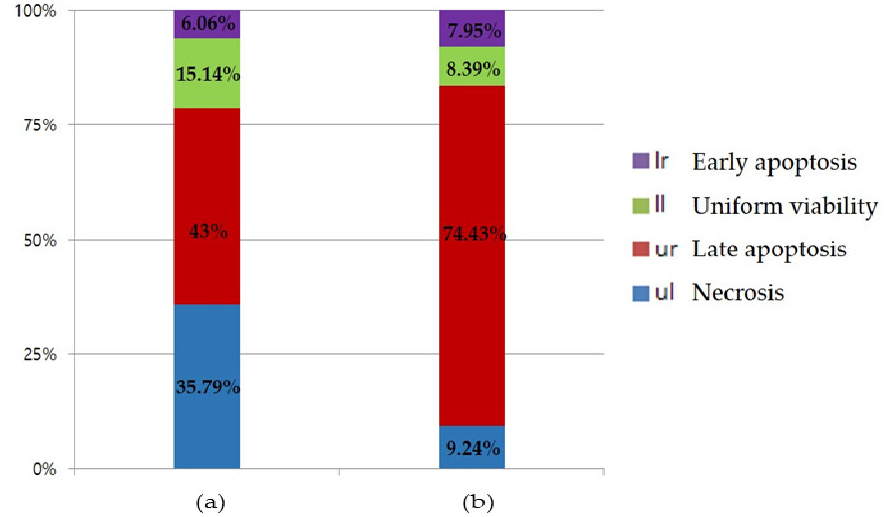
Figure 7. Flow cytometry (FACS) analysis of compounds 1 and 2 . ( a ) represents compound 1 and ( b ) represents compound 2 .